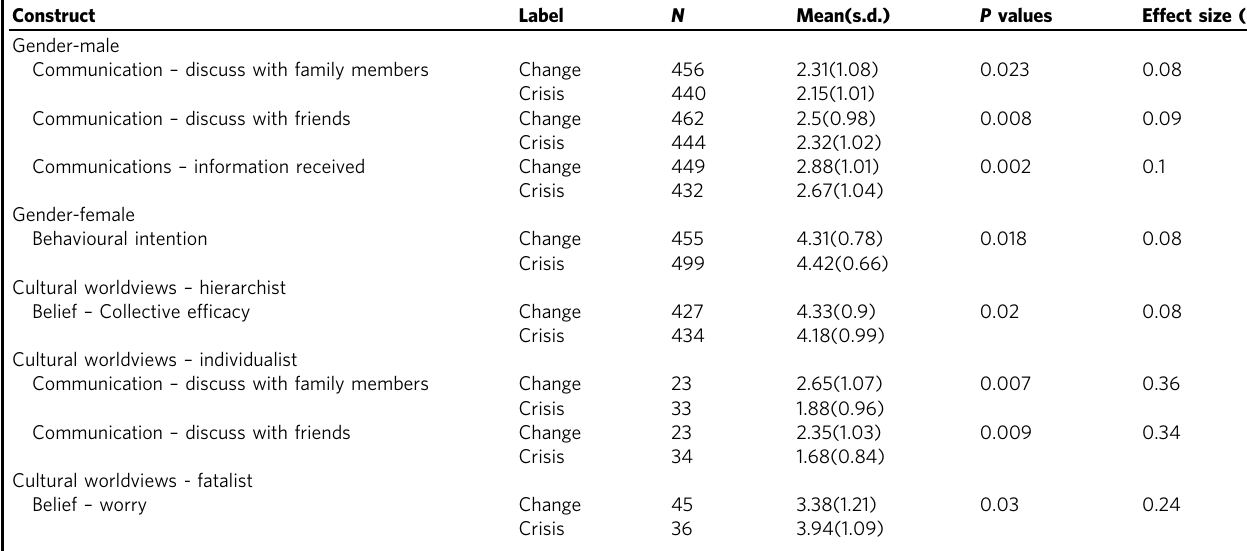
Table 2 Two-sided independent sample t -test results of labelling effects for the subgroups.